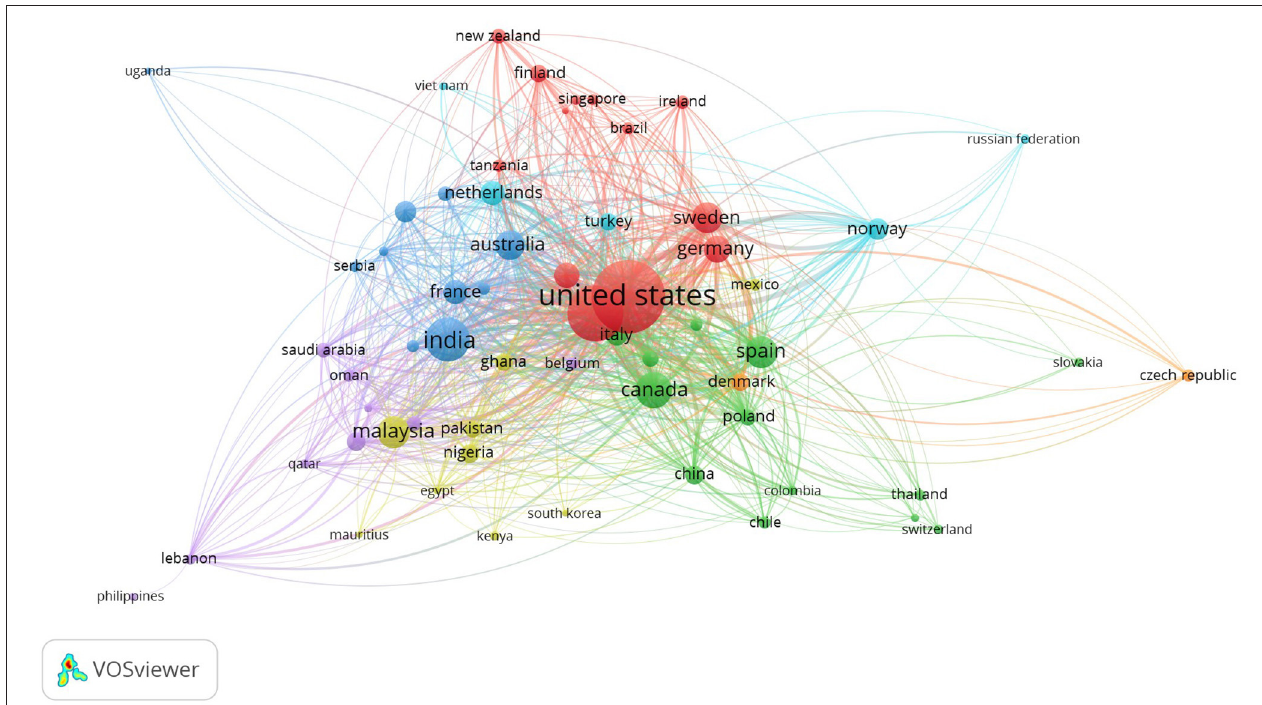
FIGURE 6 | Country analysis of the women entrepreneurship literature.